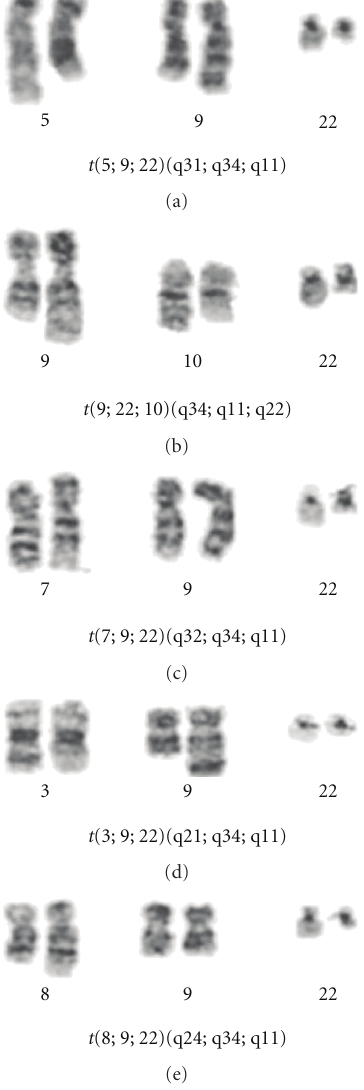
Figure 1: Partial karyotypes of the variant translocations. The letters correspond to the various patient